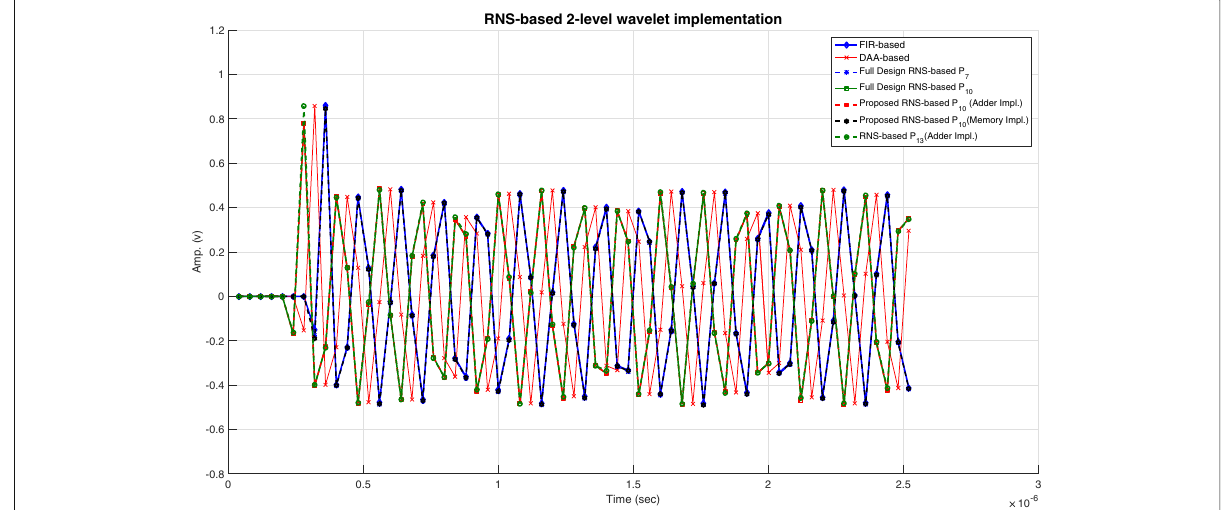
Fig. 9 Comparison among all two-level DWT approaches when a sinusoidal signal is